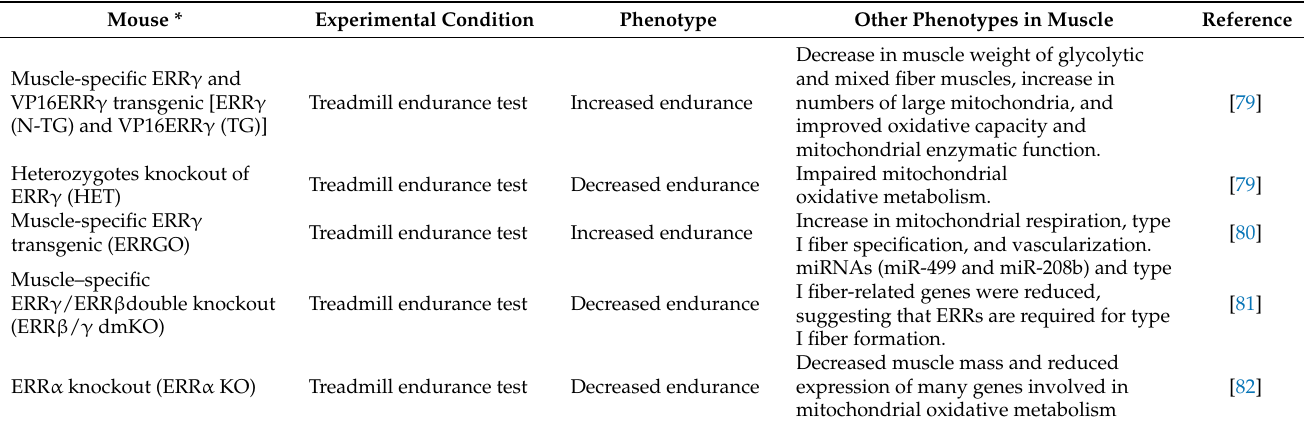
Table 3. Phenotypes of transgenic or knockout mice for ERRs on muscle